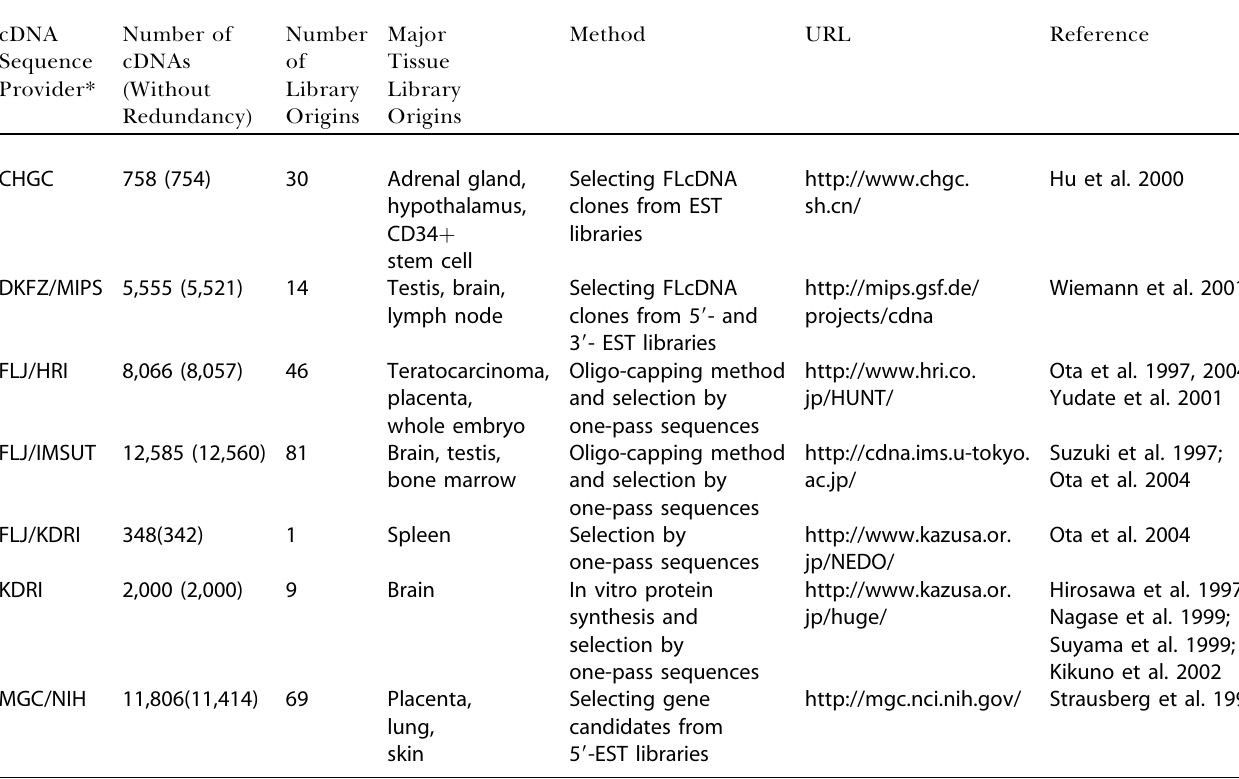
Table 1. Summary of cDNA